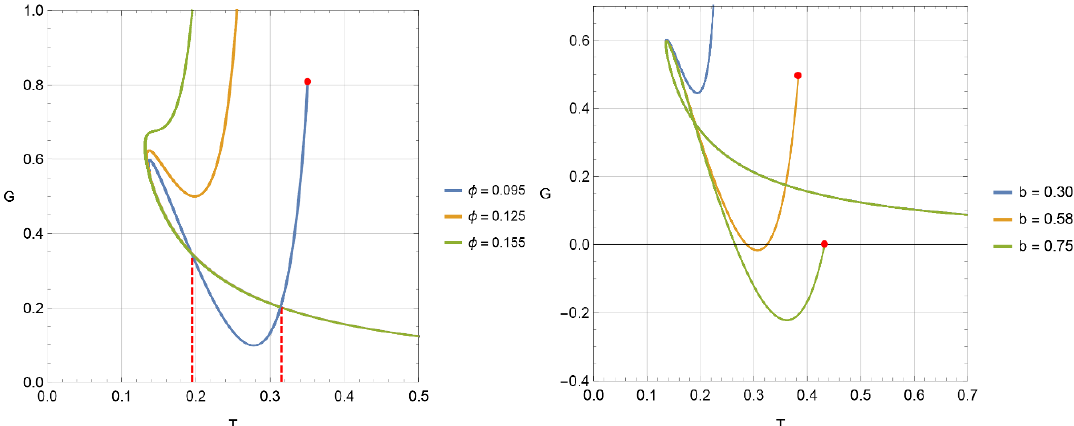
Figure 9 . Free energy of the Born-Infeld-de Sitter black hole at (cid:12)xed potential. Left : b = 0 : 5, r c = 1 : 5, and varying (cid:30) . The temperatures at which phase transitions occur are indicated by the red dashed lines. The cavity radius r c is indicated by a red dot. Right : (cid:12)xed (cid:30) = 0 : 095, r c = 1 : 5, and varying b